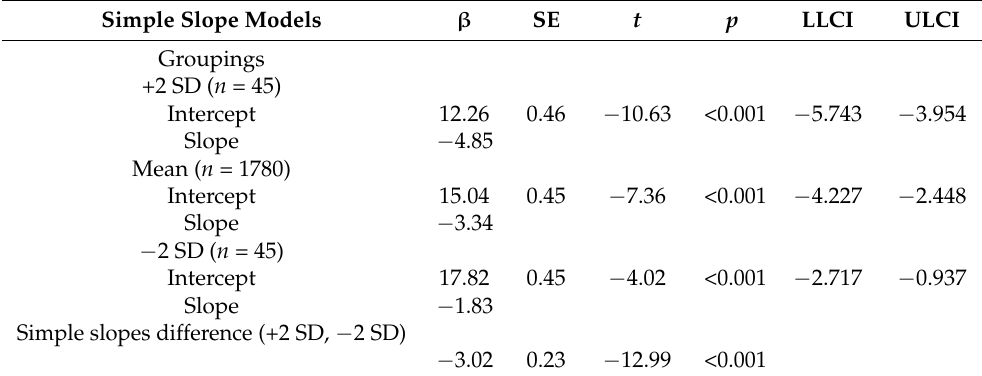
Table 8. Simple slope models for coping strategies, ISE, and depression.